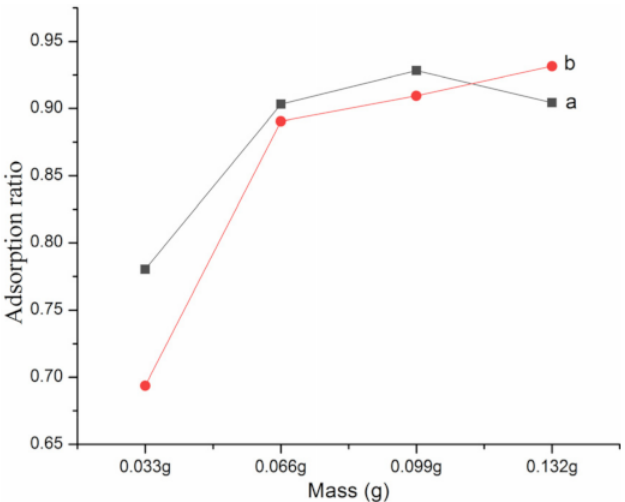
Figure 4. The equilibrium adsorption ratio of MO adsorbed by PANI ( a ) and PANI/ZnO ( b ) with different weights.